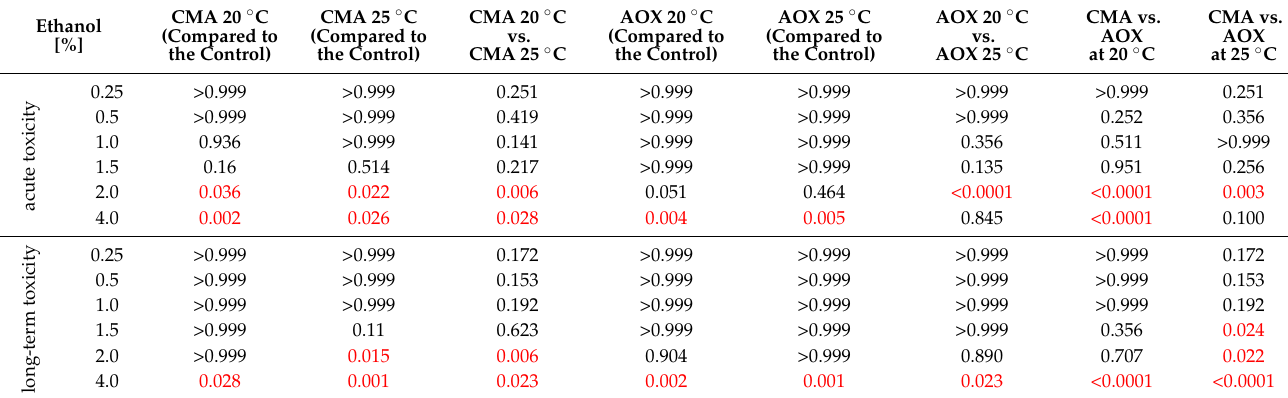
Table 1. Statistical evaluation of percentage mortality rates due to increasing ethanol concentrations in intra- and interspecies comparison of Atlantic sturgeon (AOXlar7y, AOX) and maraena whitefish (CMAfin1, CMA) at cultivation temperatures of 20 and 25 ◦ C. Significant different p values (<0.05) highlighted in